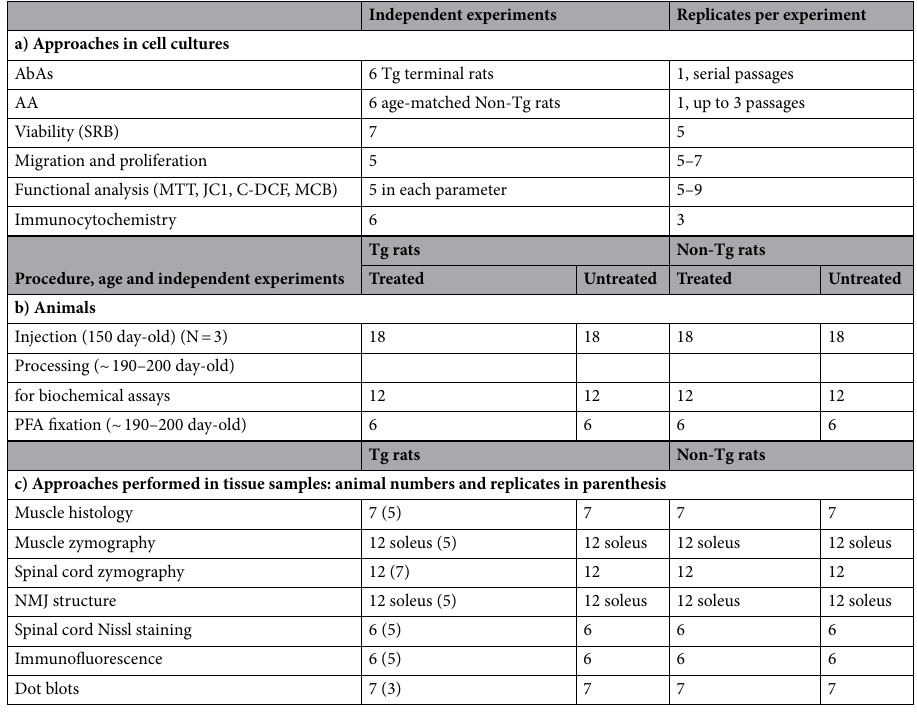
Table 1. Number of animals, experiments and replicates performed. Different sections show: a) approaches performed in vitro and b) animals employed, and c) approaches done in tissue sections or homogenates with the number of animal samples employed in each one and replicates in parenthesis. Abbreviations: C-DCF carboxy-dichlorofluorescein, MCB monochlorobimane, MTT 3-(4,5-dimethylthiazol-2-yl)-2,5- diphenyltetrazolium-bromide, NMJ neuromuscular junction, Tg Transgenic (hSOD1G93A) rats, Non-Tg Non transgenic rats, PFA paraformaldehyde.